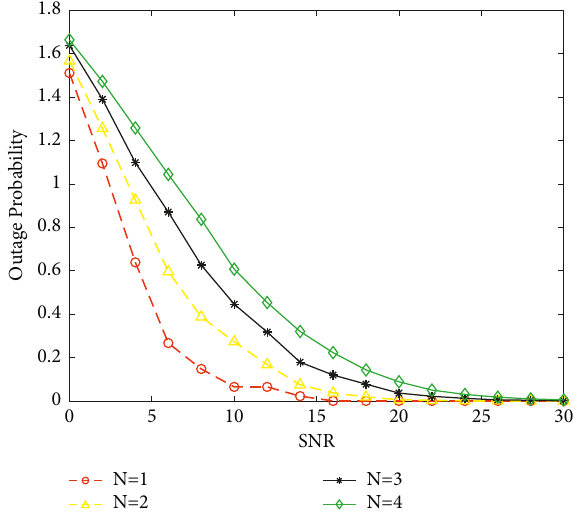
Figure 3: The OP performance with different ( N